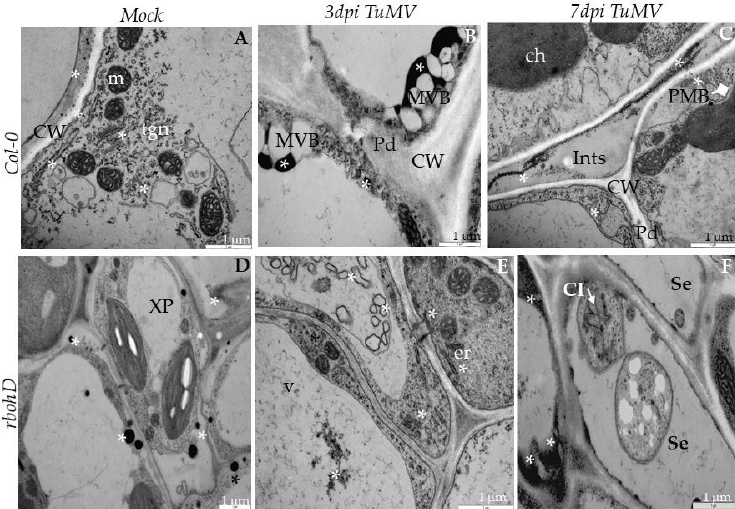
Figure 12. H 2 O 2 detection in Col-0 and rbohD mock-inoculated leaf tissues ( A , D ) and 3 ( B , E ) and 7 days ( C , F ) post-TuMV inoculation examined under TEM. ( A ) Electron-dense deposits of cerium perhydroxide (*) in the cell wall and along the trans Golgi network (tgn) and vesicles in the cytoplasm of Col-0 spongy mesophyll cell. CW—cell wall; m—mitochondrion. ( B ) H 2 O 2 (*) around multivesicular bodies (MVBs) in Col-0 epidermis. Pd—plasmodesmata; CW—cell wall. ( C ) H 2 O 2 (*) in cell wall (CW), intercellular space (Ints) and near paramural bodies (PMB; diamond arrowhead) in Col-0 mesophyll cells. ( D ) H 2 O 2 (*) in the apoplast between cell wall and plasmalemma in rbohD mock- treated xylem cells. XP—xylem parenchyma. ( E ) H2O2 (*) in vacuoles (vs), vesicular structures and endoplasmic reticulum (er) in cytoplasm in rbohD phloem parenchyma cells. ( F ) H 2 O 2 (*) in phloem parenchyma cells with cytoplasmic inclusions (Cis; white arrow) of TuMV in rbohD sieve element (Se).